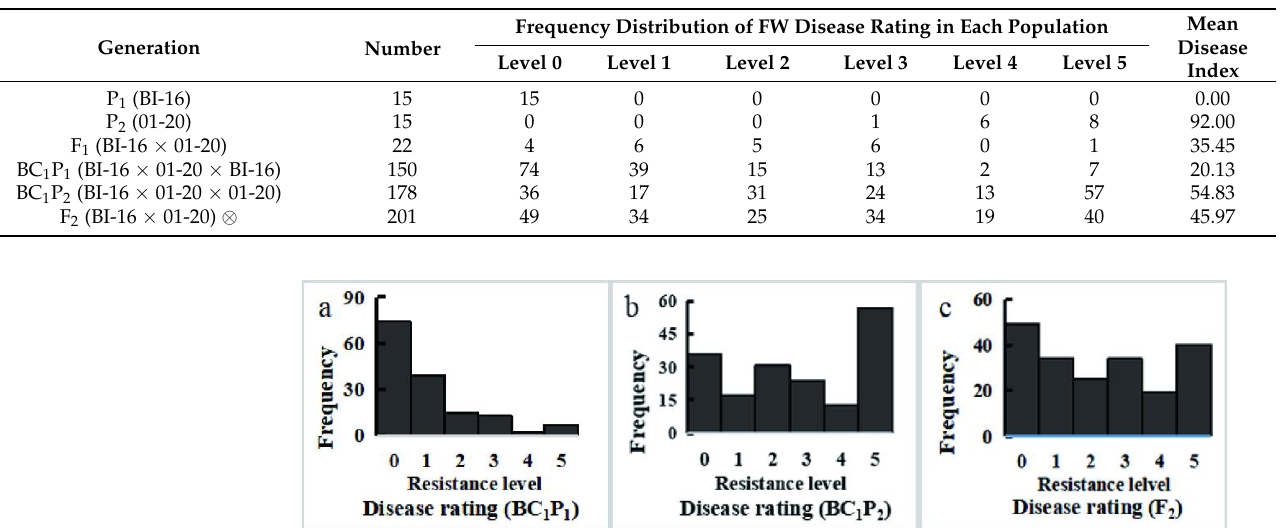
Table 2. Frequency distribution of CFW resistance levels in segregated populations derived from ‘BI-16’ and ‘01-20’.